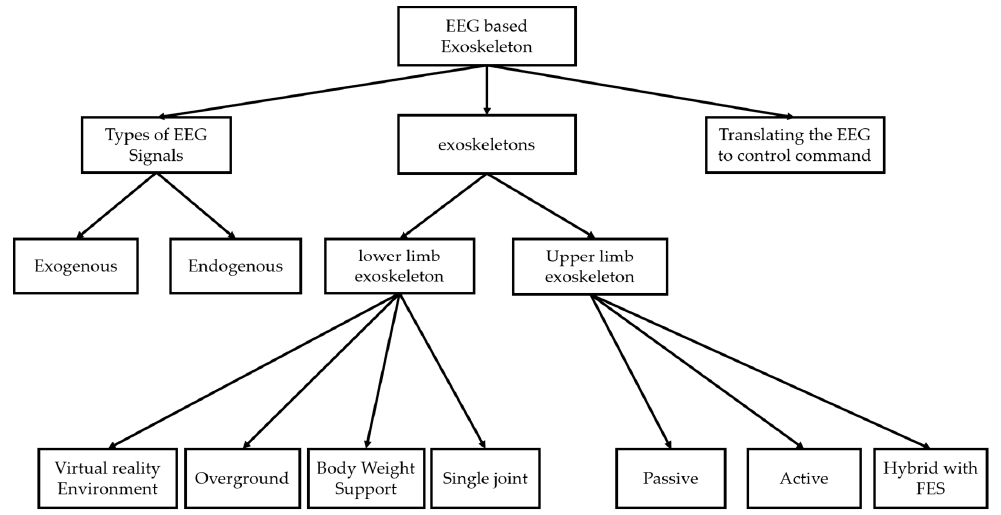
Figure 4. Research outcome.